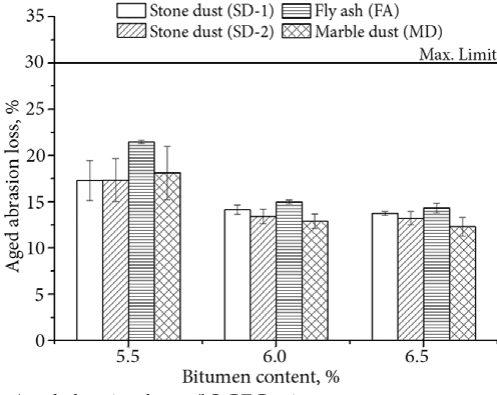
Fig. 7. Unaged abrasion loss of OGFC mixes Fig. 8. Aged abrasion loss of OGFC